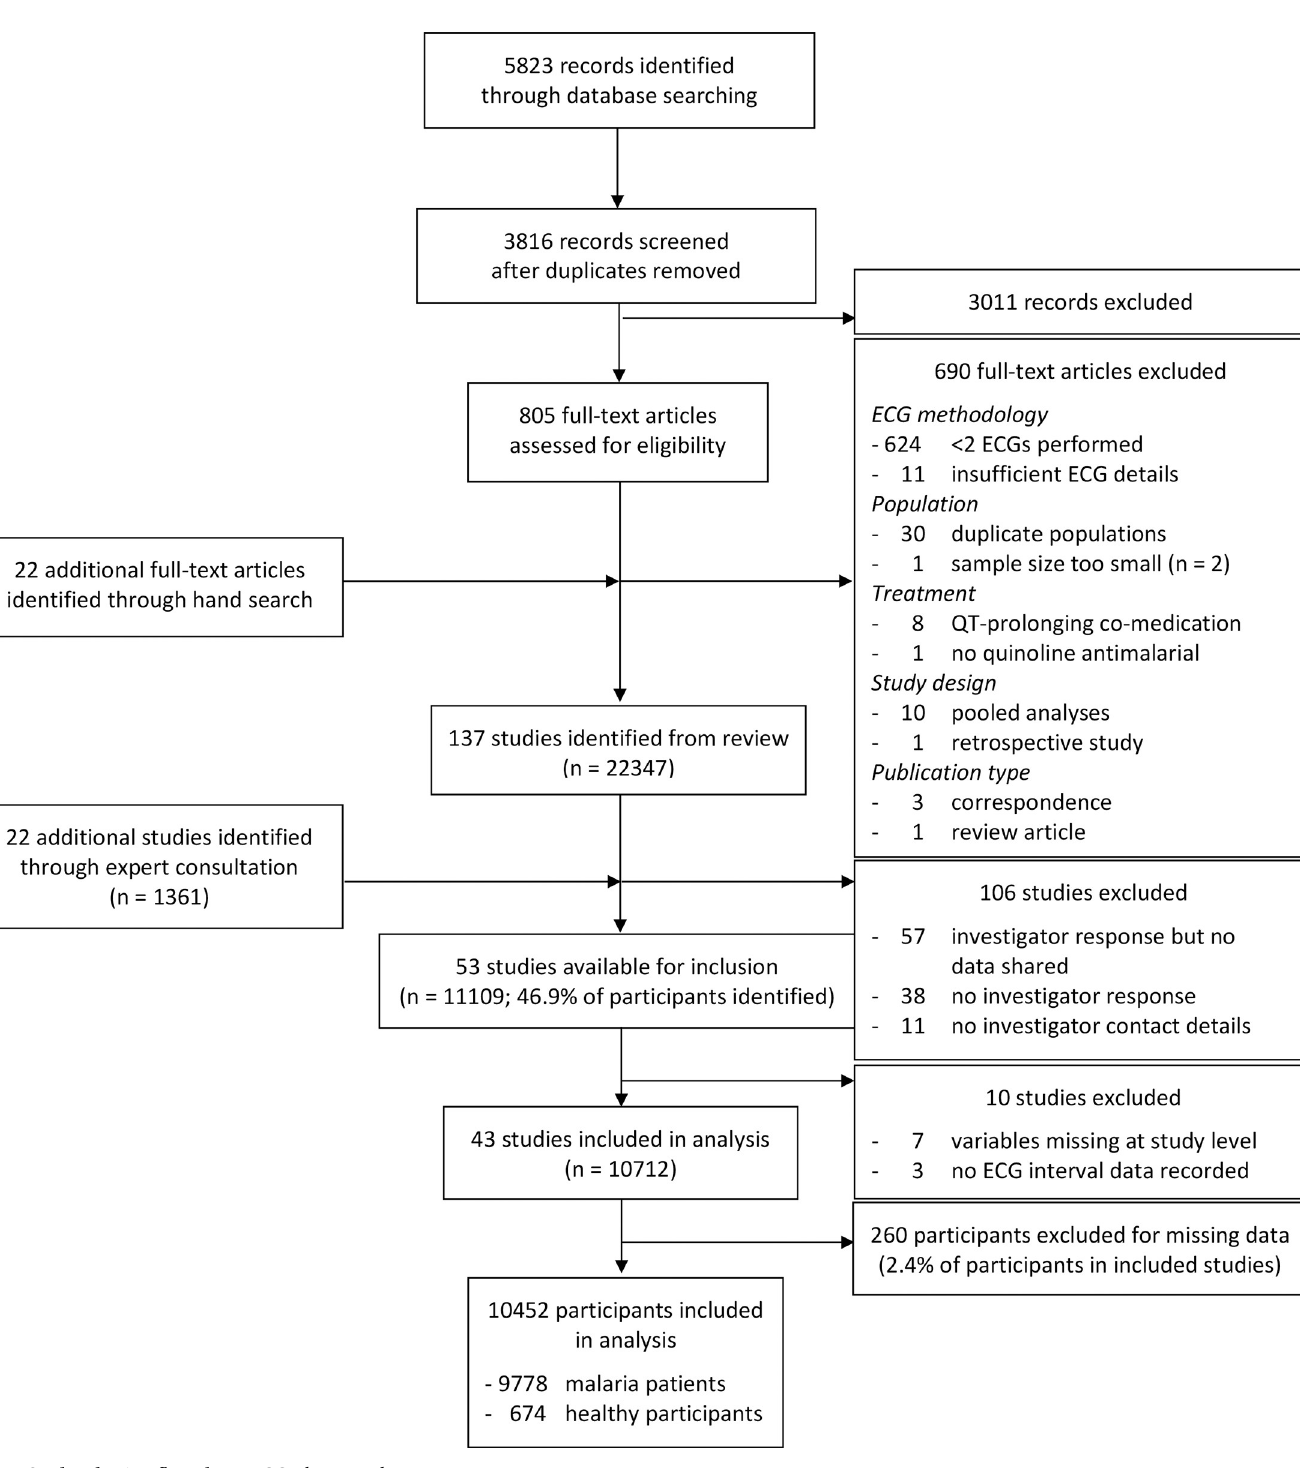
Fig 1. Study selection flow chart. ECG, electrocardiogram.